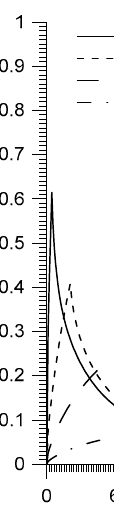
Figure 20. Model methane emission based on the plane sheet model during Budryk outburst.